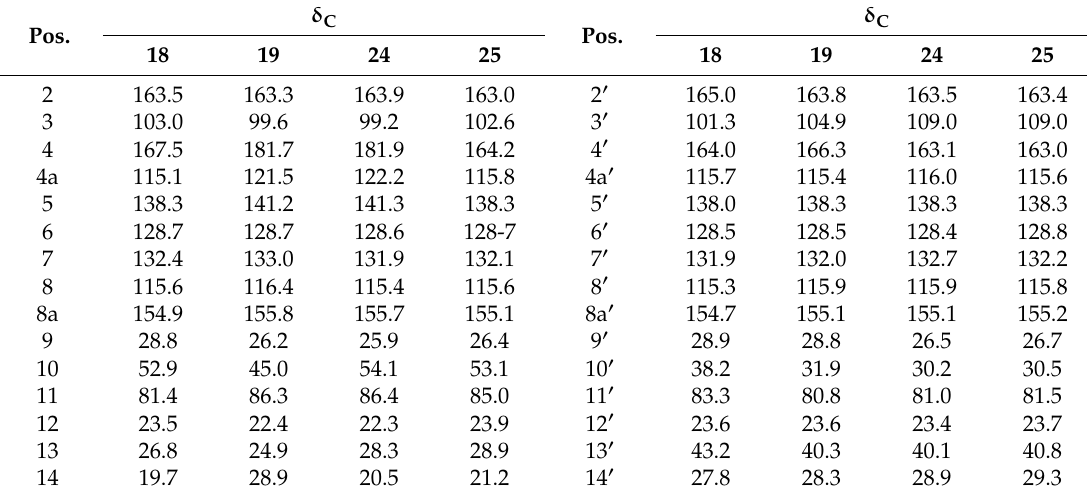
Table 4. 13 C NMR (150 MHz) Spectroscopic Data of 18 , 19 , 24 , and 25